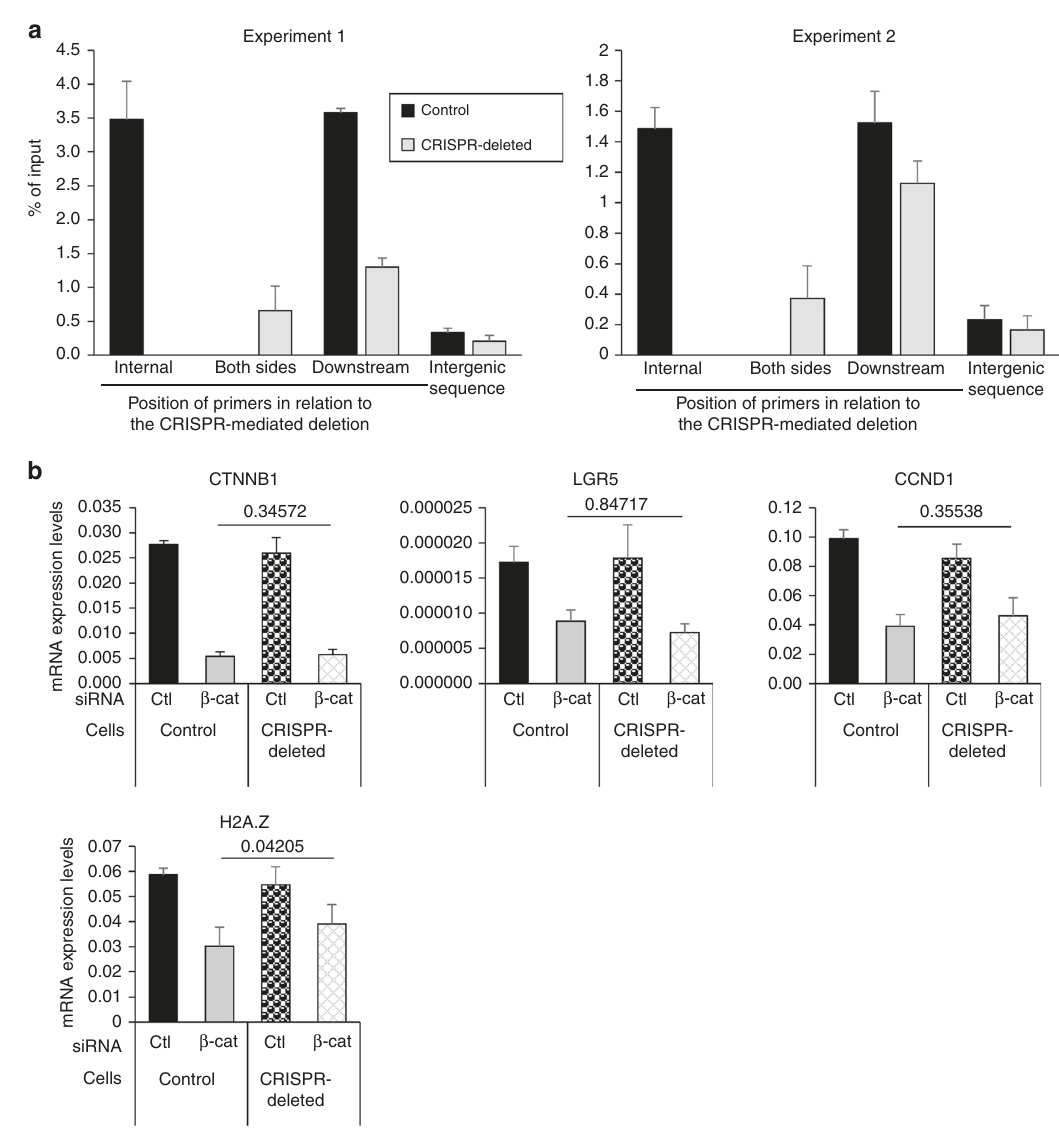
Fig. 8 H2A.Z is an effector of the Wnt pathway on differentiation markers. a Chromatin from sub-con fl uent CRISPR-Cas9-modi fi ed HCT116 cells to homozygously delete the major TCF7L2 binding region of the H2AFZ gene promoter, using indicated H2AFZ promoter — speci fi c or intergenic sequence — targeting primers. Results and standard errors ( n = 3 technical replicates) are shown for two independent experiments. b Control or CRISPR-modi fi ed HCT116 cells were transfected using β -catenin — targeting or control siRNA. 72h later, total RNA was extracted and subjected to RT-qPCR analysis for expression of the indicated genes (calculated relative to GAPDH and β -actin mRNA levels). The mean and standard errors are shown ( n = 4 independent experiments). The Student ’ s t -Test p -value was calculated (for β -catenin -depleted samples from control vs CRISPR-modi fi ed cells) and is indicated for each